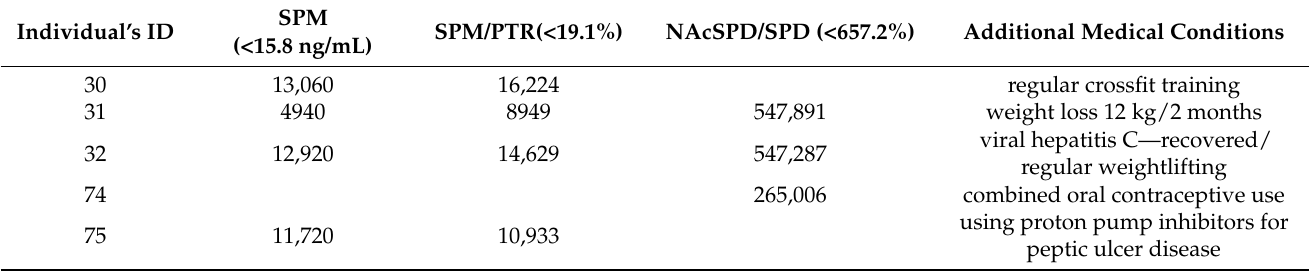
Table 1. Healthy subjects with low PA levels (within Q1 range) and their concurring or medical conditions.